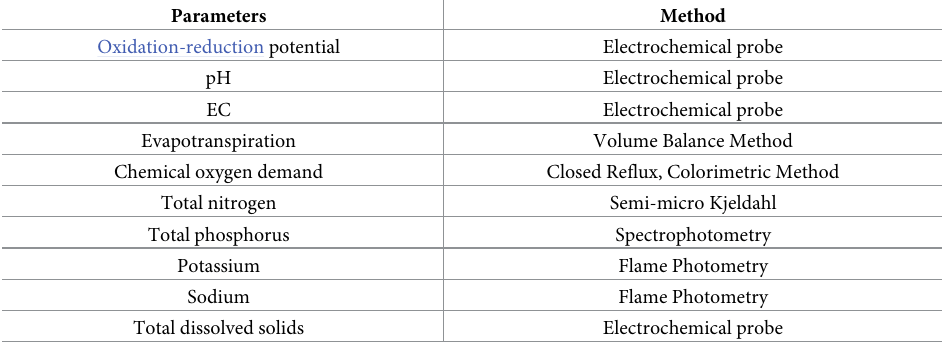
Table 6. Parameters analyzed while monitoring CWs and